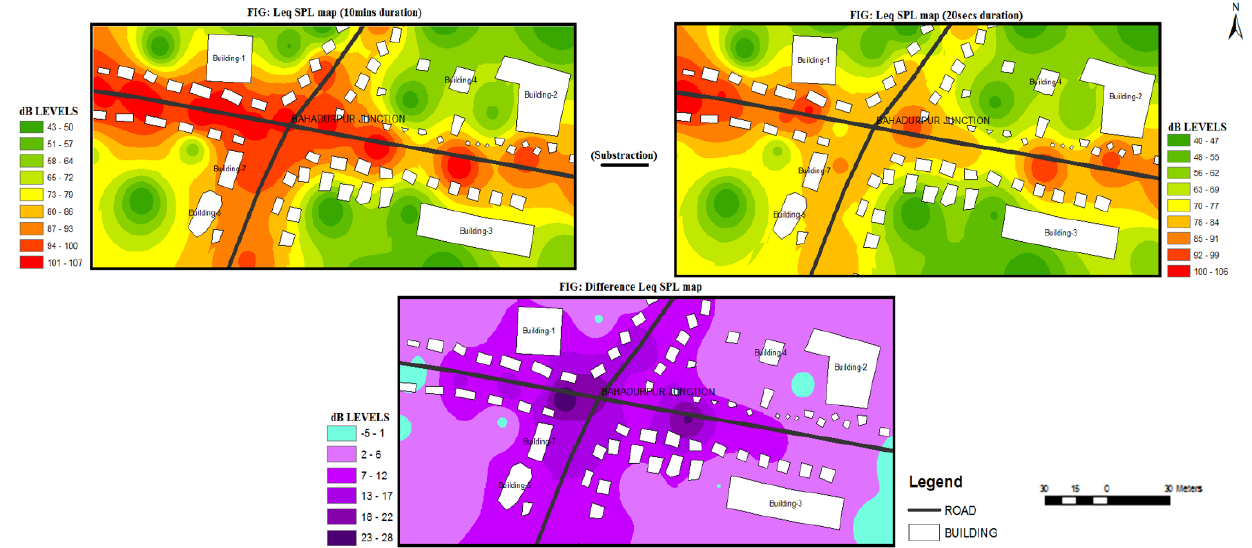
Figure 16. Long vs short noise sampling duration based noise prediction and their difference at M2 time interval (9am–1pm) for the Bahadurpur study area.